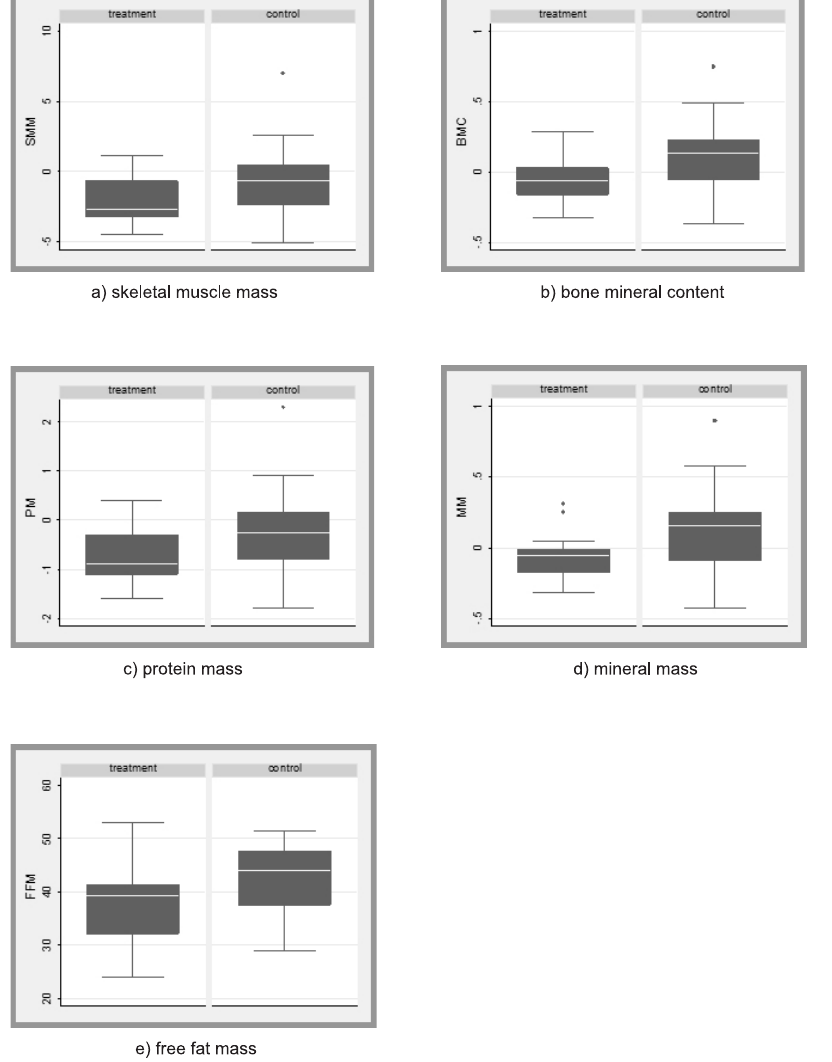
Figure 3. Box plots for parameters between the treatment and control group in the female